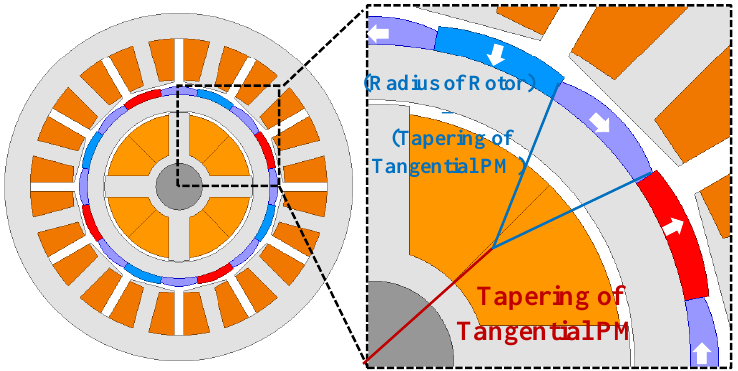
Figure 21. Rotor variable for tapering of tangential PM.